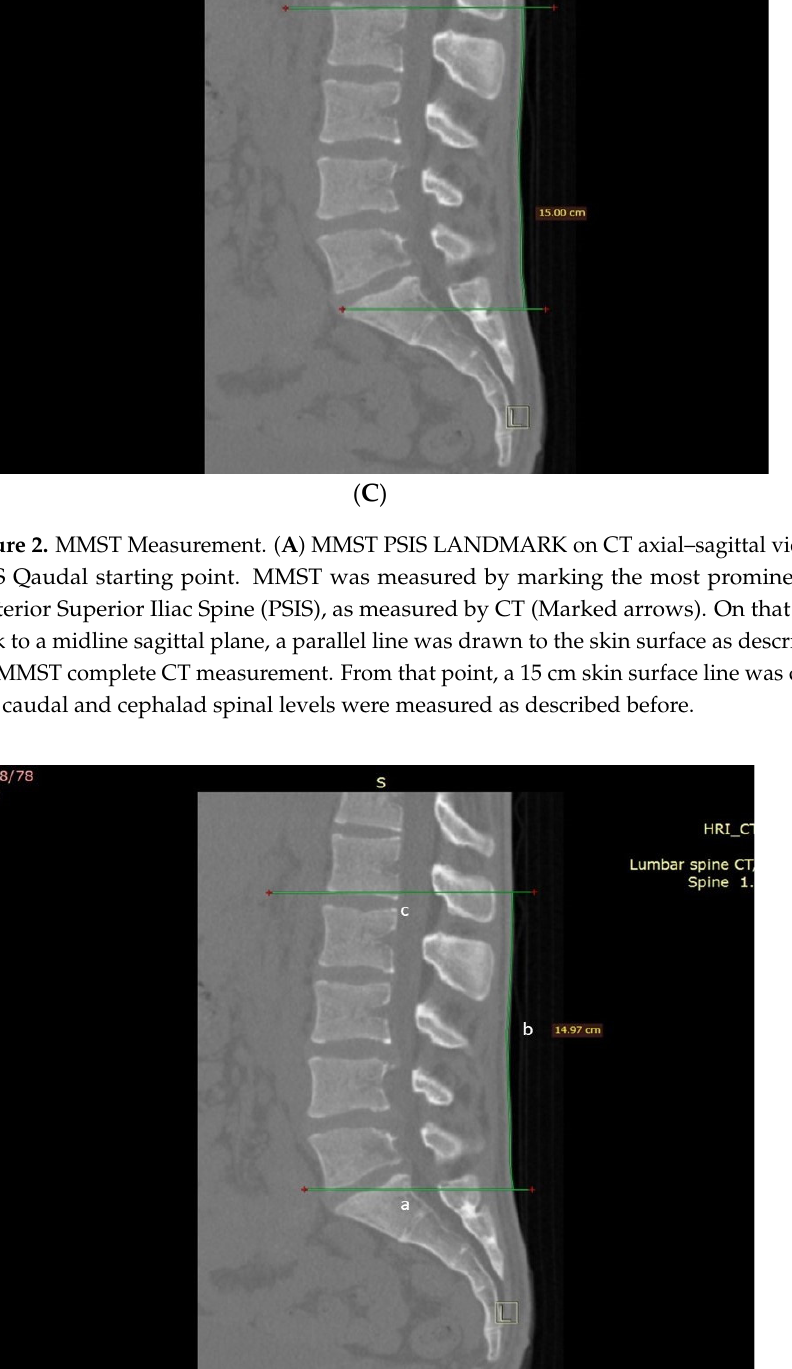
Figure 3. Actual lumbar (L1-S1) motion segments length measurement on CT. A line was stretched from the mid-endplate of S1 to the skin surface (marked as a), and a parallel line was extended from the mid-endplate of L1 to the skin surface (marked as c). The distance between both lines was measured on the skin surface (marked as b).